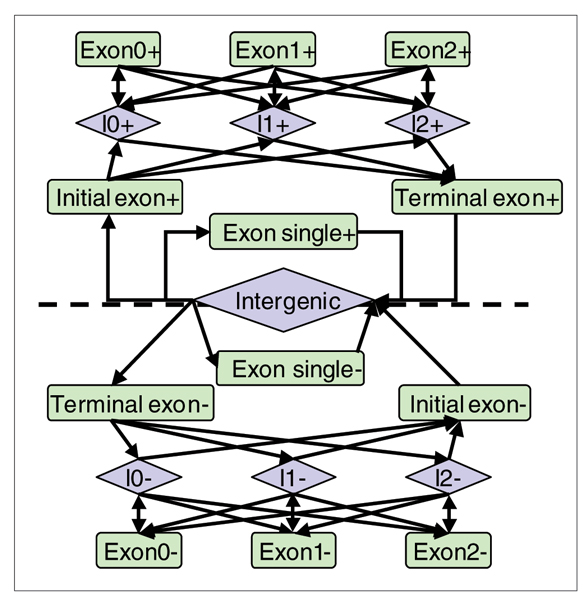
State-transition diagram of the GHMM for GlimmerHMM. The dashed line in the middle separates the positive strand and negative strand portions of the model. Each state in the GHMM is implemented as a separate submodel, such as a weight array matrix or an IMM (interpolated Markov models).